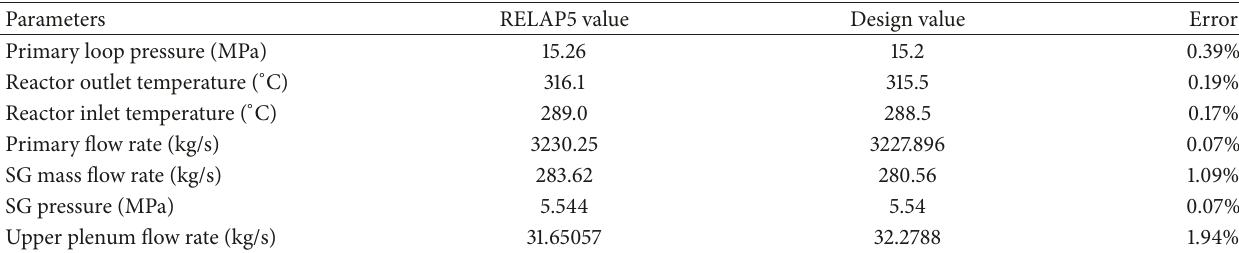
Table 2: Steady calculation results and comparison with design value.